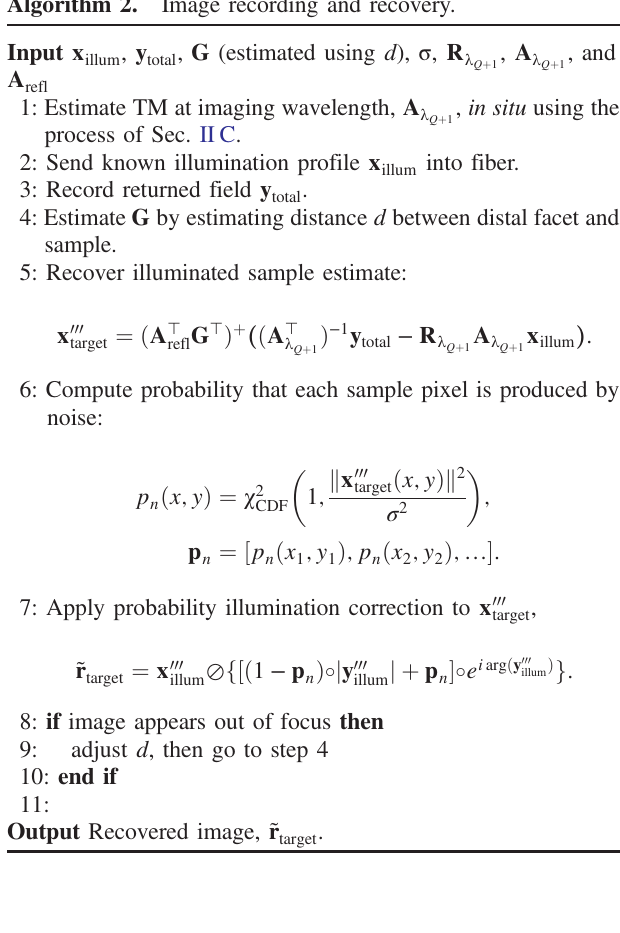
Algorithm 2. Algorithm 2. Image recording and